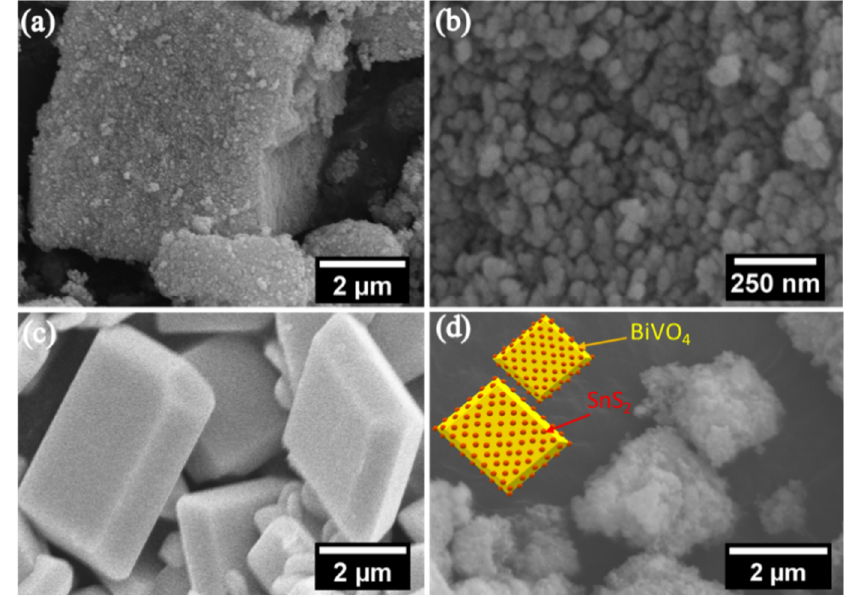
Figure 2. FE-SEM micrographs of ( a ) SnS 2 , ( b ) magnified image of SnS 2 , ( c ) BiVO 4 , and ( d ) 0.03 BiVO 4 /SnS 2 with schematic illustration. Table 1. Comparison of molar / weight percent BiVO 4 , specific surface area, and pseudo-first-order-kinetic degradation constant, for SnS 2 , BiVO 4 , and BiVO 4 / SnS 2 composites with various BiVO 4 -to-SnS 2 ratios. Sample